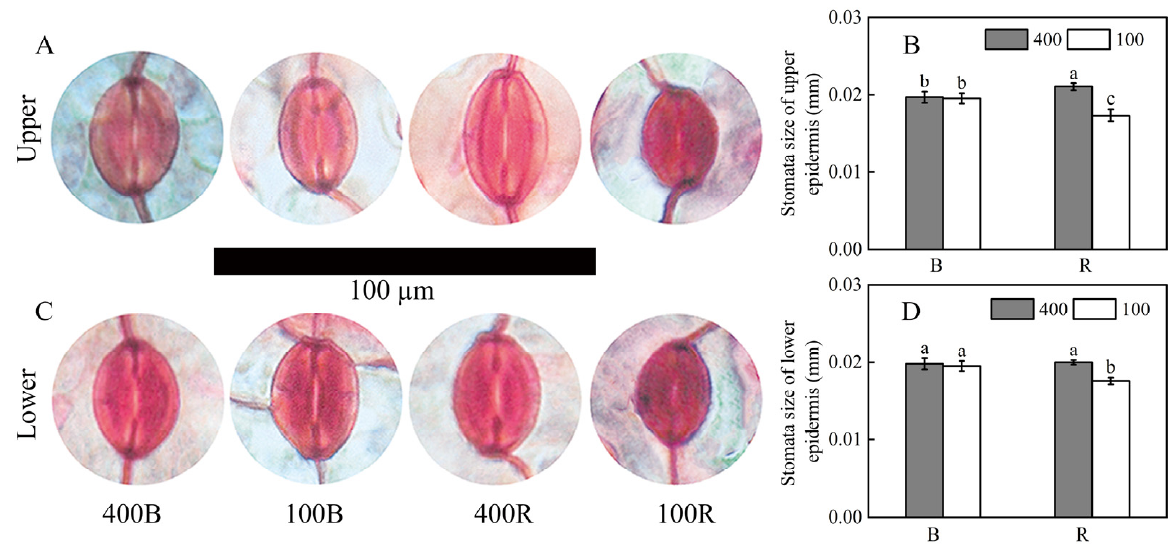
Figure 2. The response of stomatal size to various light treatments. ( A , B ) Stomatal size on the upper epidermis. ( C , D ) Stomatal size on the lower epidermis. 400 B and 100 B denote the blue light with 400 µ mol m − 2 s − 1 and 100 µ mol m − 2 s − 1 , respectively. 400 R and 100 R denote the red light with 400 µ mol m − 2 s − 1 and 100 µ mol m − 2 s − 1 , respectively. The mean ± SE is expressed by each value. Different lowercase letters indicate significant differences between treatments ( p ≤